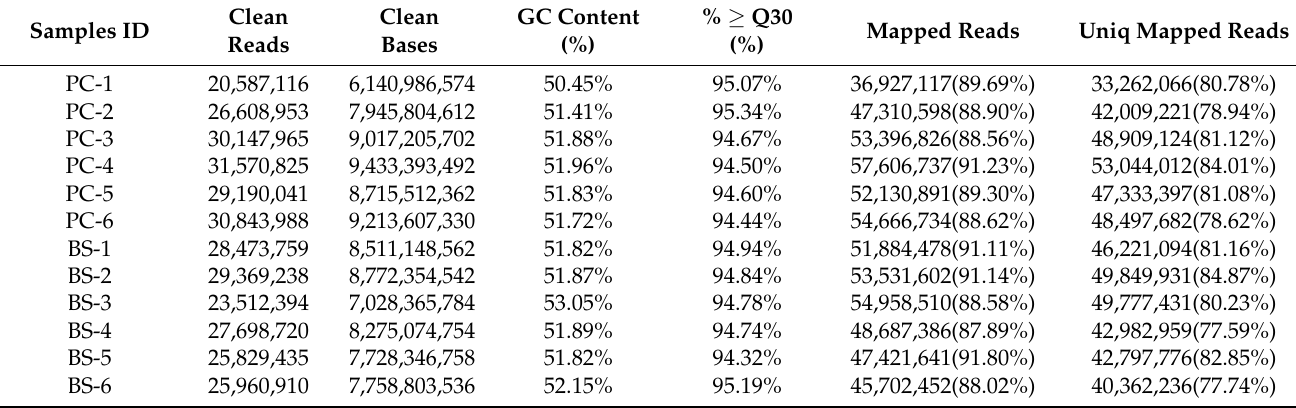
Table 3. Characteristics of the reads from 12 duck’s jejunum libraries.